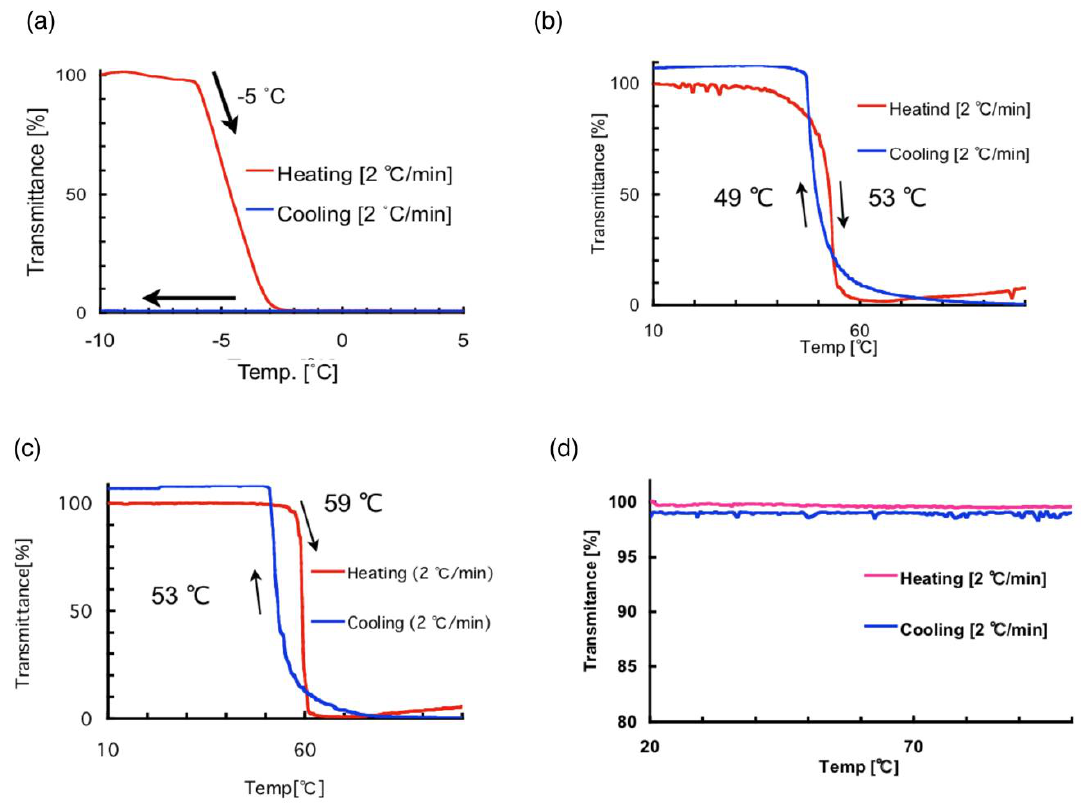
Figure 2. Effect of temperature on transmittance of 35 wt% hydrazine aqueous solutions containing 16 mg/mL of ( a ) PNIPAM, ( b ) PDMAM, ( c ) PVP, and ( d ) PAM (scan rate = 2 °C/min, pathlength = 10 mm).